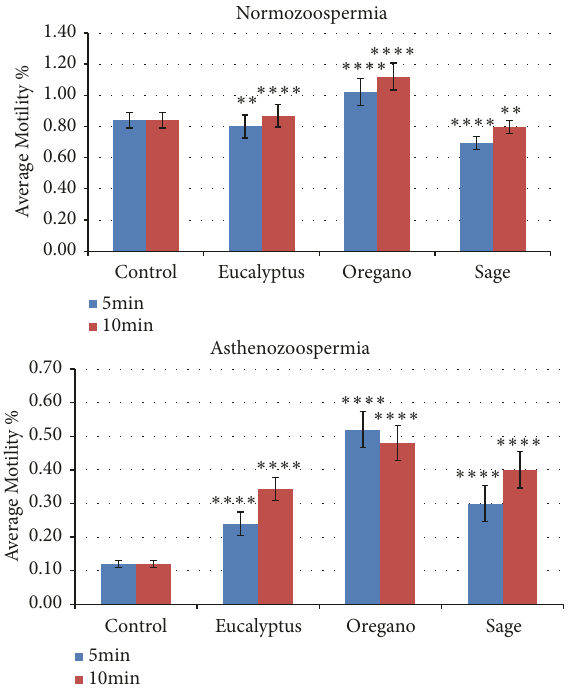
Figure 3: The in vitro effect of EOs on the proportion of spermatozoa with a vitality ≥ 58%. We prepared the dilution of EOs in a sterile solution of agar at 0.2% (w / v) for a range concentration of 10 −1 , 10 −2 , 10 −3 , and 10 −9 . The motility percentage of each aliquot was measured immediately after the supplementation with the HE (t = 5 min) and 10 minutes later (t = 10 min). The data are expressed as mean ± standard deviation (n = 5). ( ∗ ) indicates “p” values: ∗ significant (p < 0.05); ∗∗ highly significant (p < 0.01); ∗ ∗ ∗ highly significant (p <